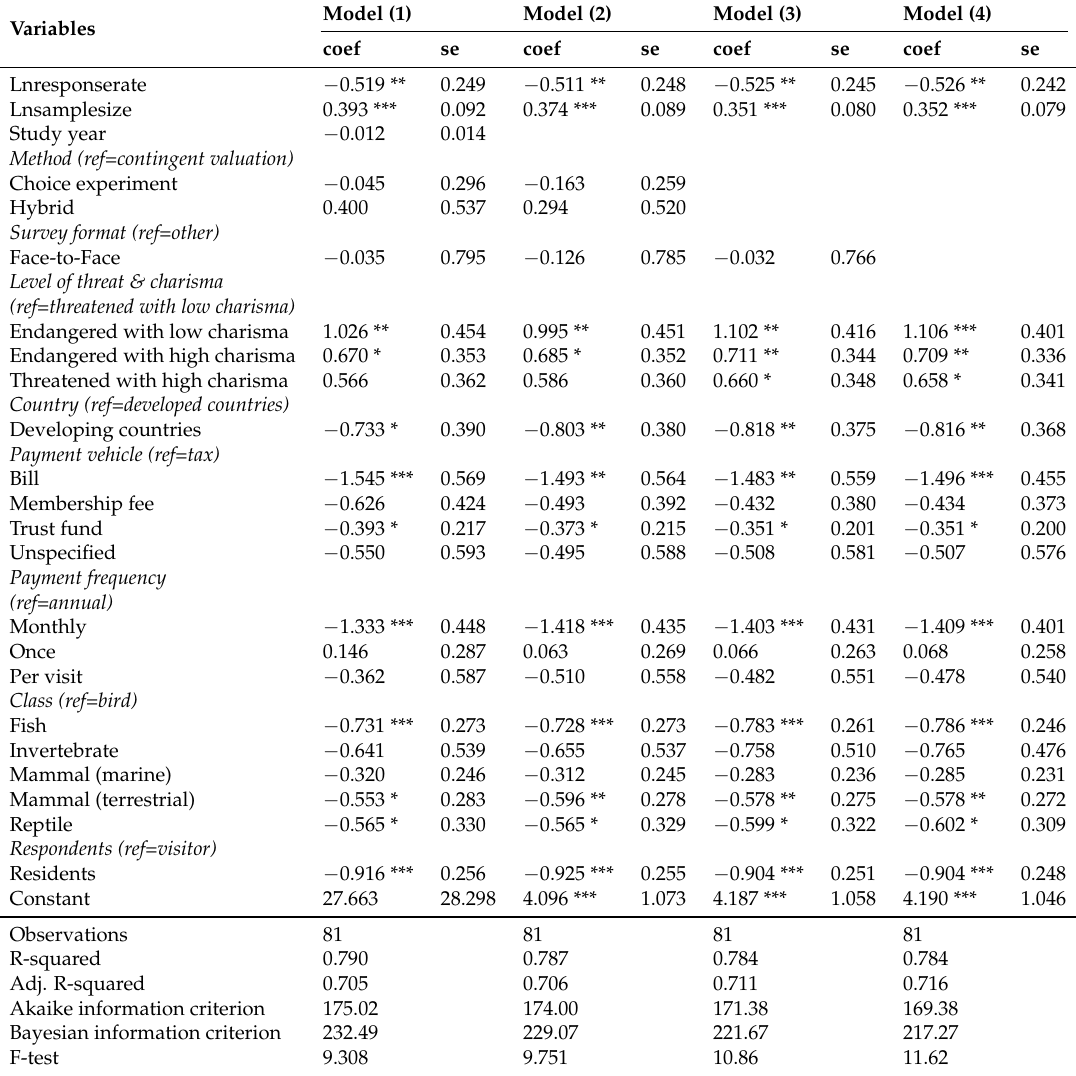
Table 3. Full and reduced form WTP